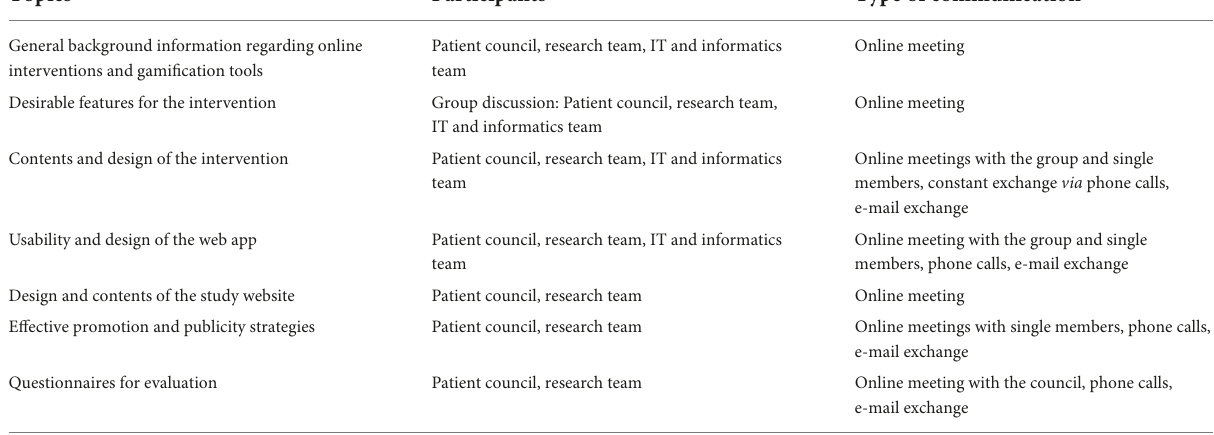
TABLE 1 Overview of the cooperation with the patient